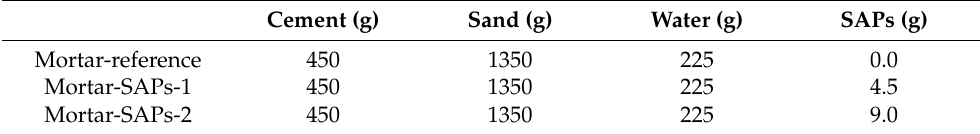
Table 1. Composition of the mortar specimens.